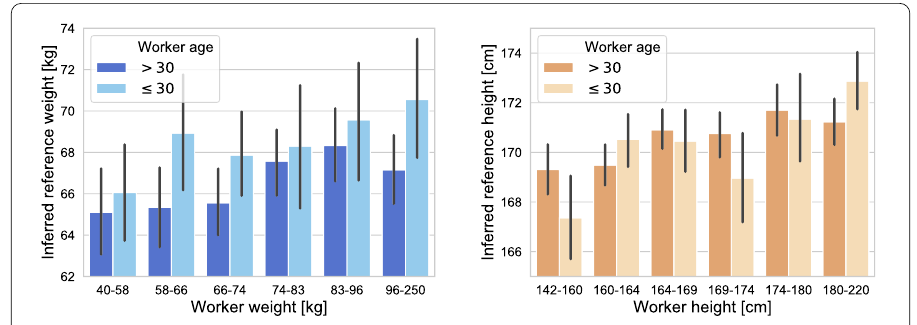
Figure 18 Dependence of reference values on measurements and age for workers from the U.S